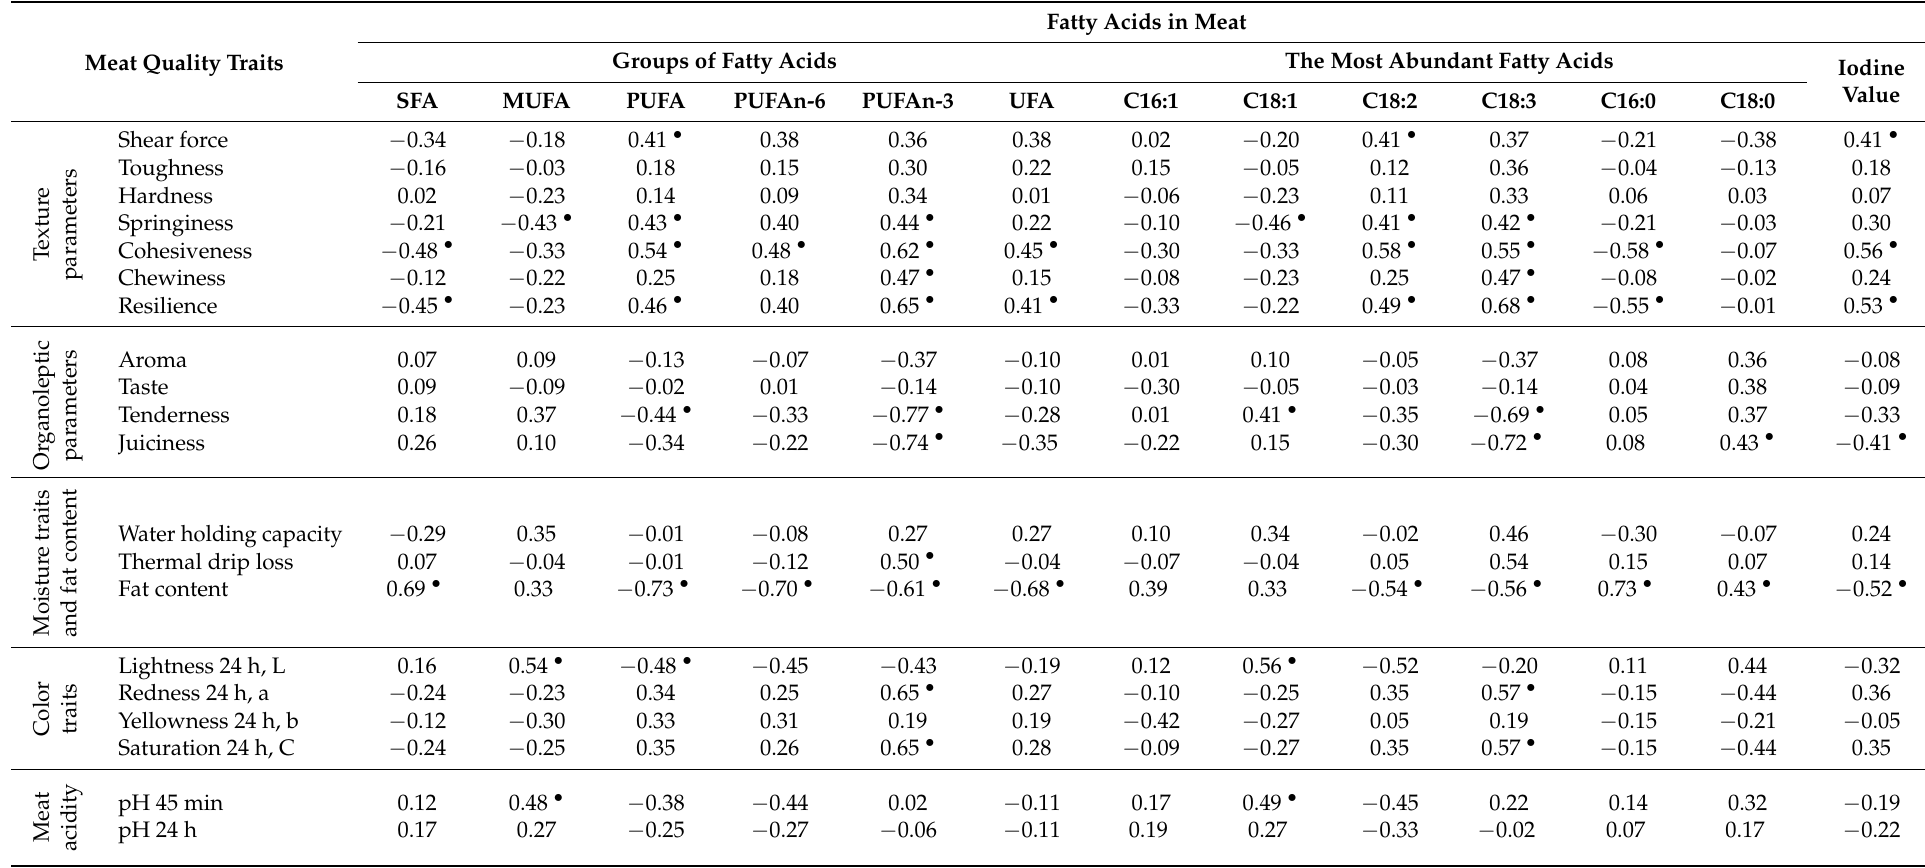
Table 6. Correlation coefficients between groups of fatty acids in meat ( longissimus m.) and chosen meat quality traits.